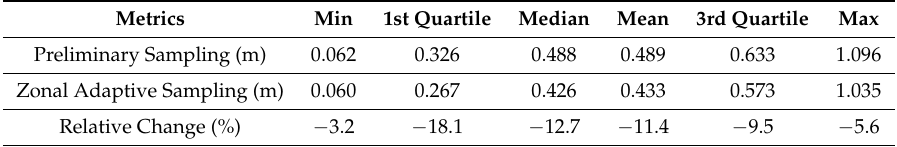
Figure 4. Spatial distribution of the clustered standard deviation (SD in m) ( A ) after the initial sampling and ( B ) after the zonal adaptive sampling. Table 1. Statistical quartiles of the clustered standard deviation and its percent change calculated at the inital 1212 pivots for the preliminary and zonal adaptive